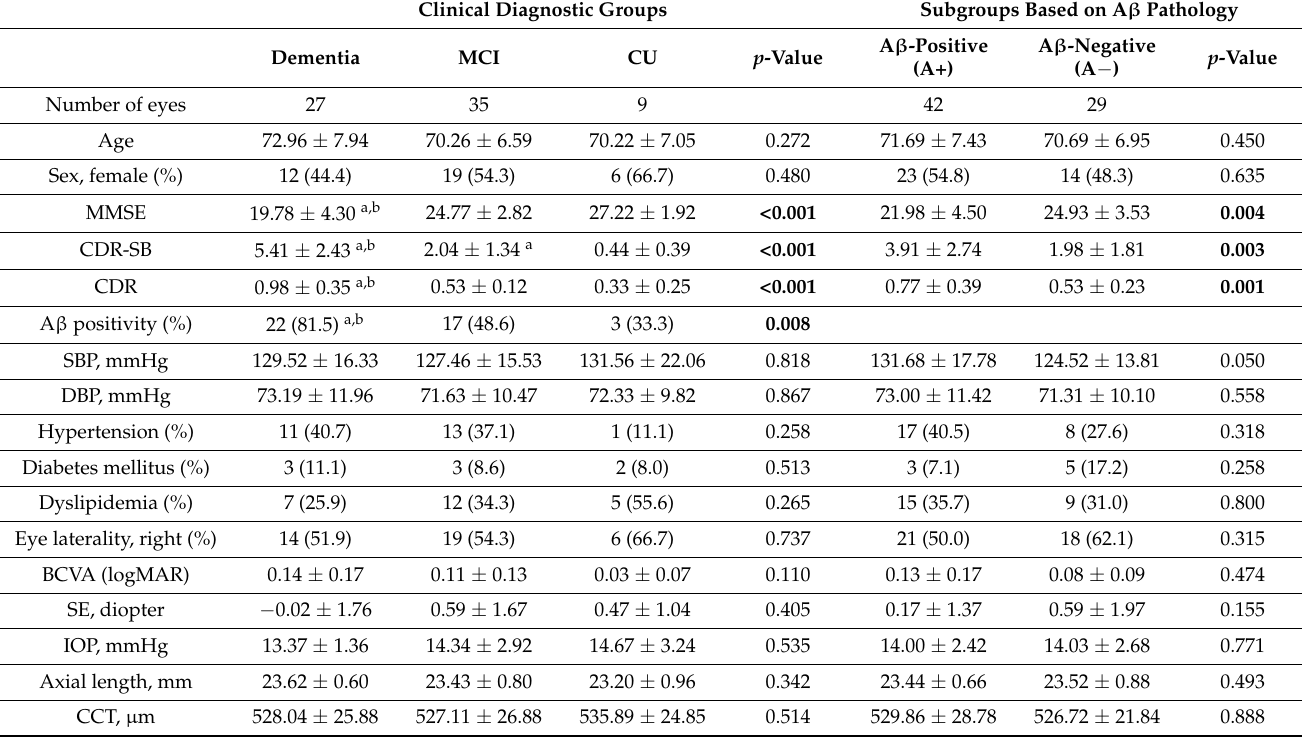
Table 1. Demographics and clinical